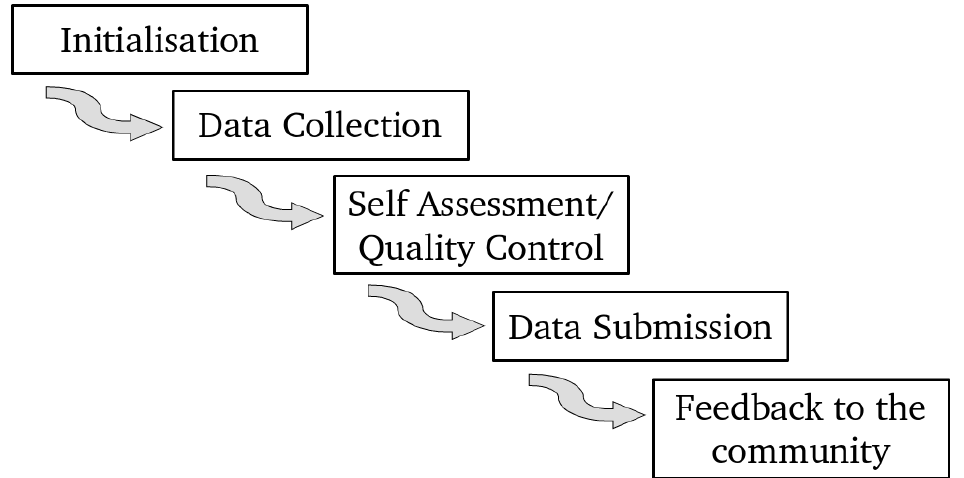
Figure 2. Sequence of the five main stages of the protocol for VGI vector data collection.